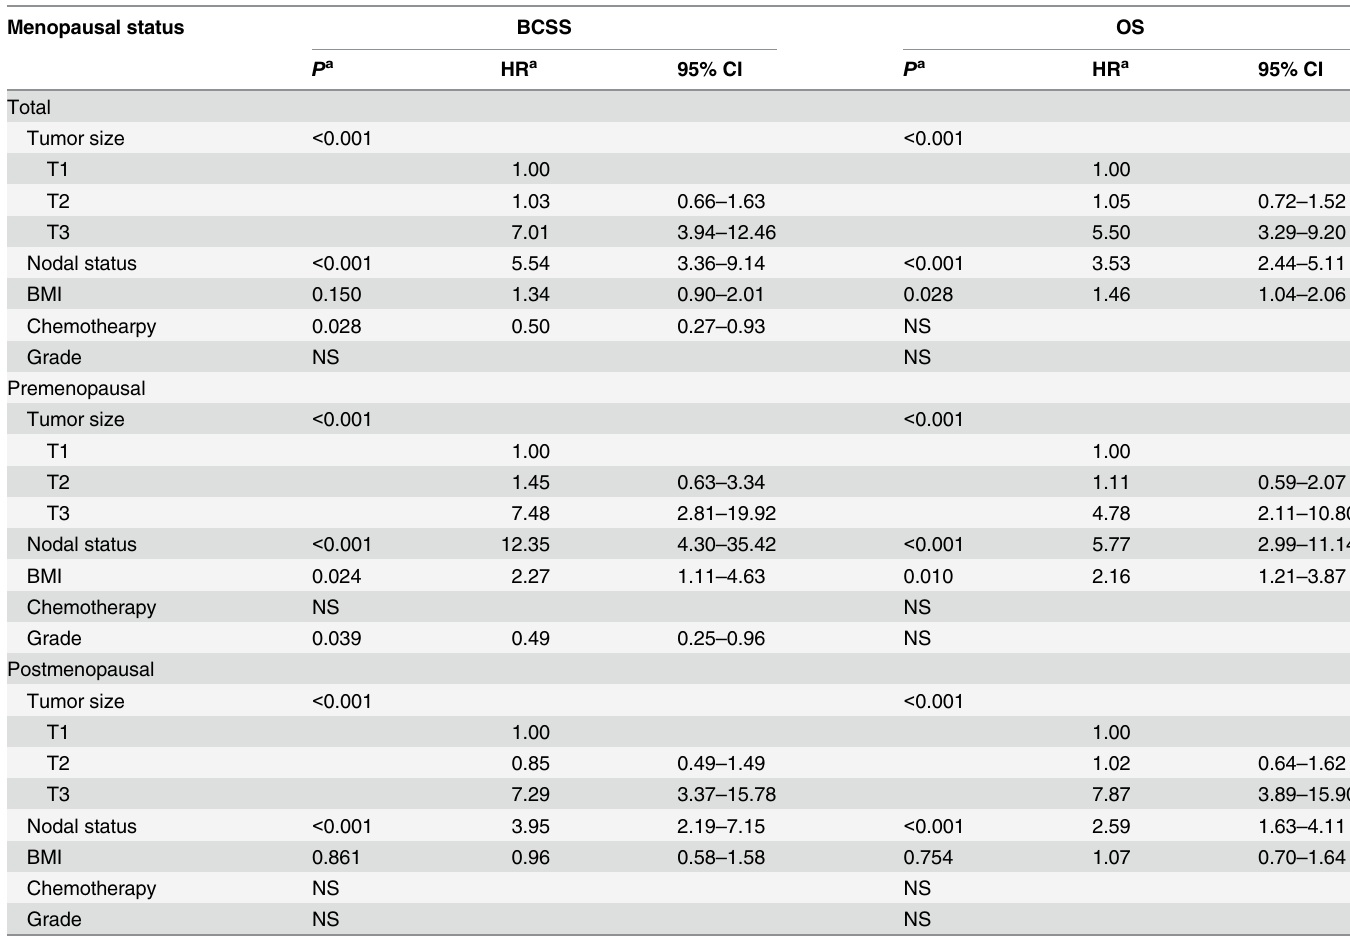
Table 2. Multivariate survival analysis in TNBC patients.